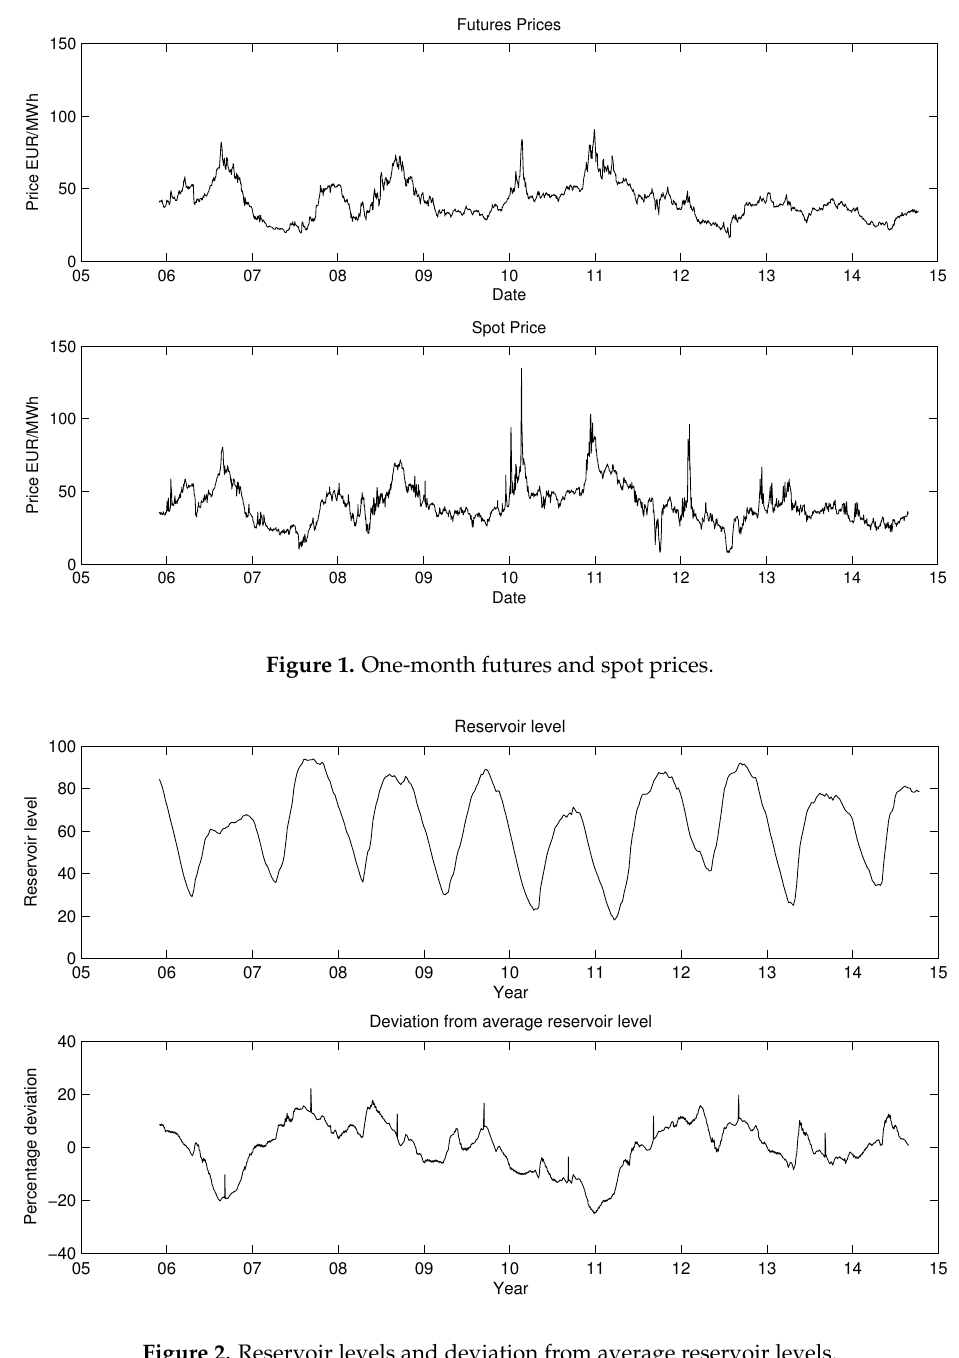
Figure 2. Reservoir levels and deviation from average reservoir